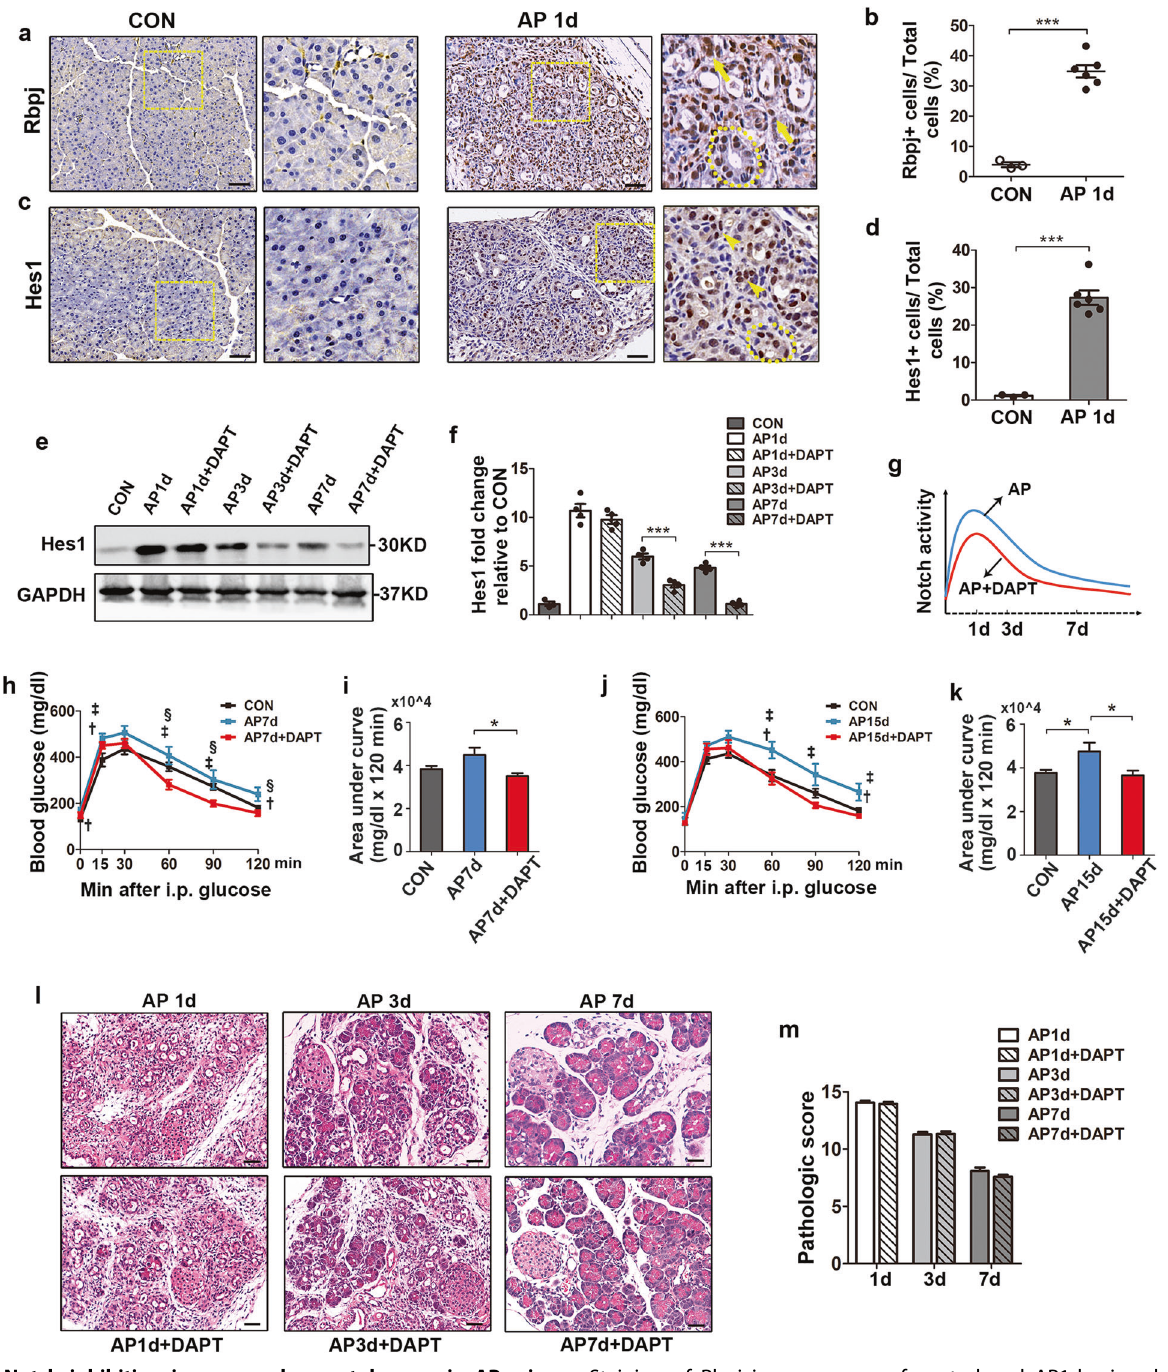
Fig. 5 Notch inhibition improves glucose tolerance in AP mice. a Staining of Rbpj in pancreases of control and AP1d mice showing prominent Rbpj immunoreactivity in pancreases of AP mice. b Quanti fi cation of Rbpj + cells (shown as %) in pancreases from control and AP1d mice. c Immunostaining of Hes1 in pancreases of control and AP1d mice showing prevalent Hes1 staining in pancreases of AP1d mice compared with control pancreases. d Quanti fi cation of Hes1 + cells (shown as %) in pancreases from control and AP1d mice. e Representative western blots of Hes1 in pancreases from control mice, AP mice and AP mice treated with DAPT. f Quanti fi cation of western blots for Hes1 in pancreases from AP mice and AP mice treated with DAPT in relative to control mice. g Schematic representation of Notch activity in pancreases from AP mice and mice treated with DAPT at indicated time points. h , i Blood glucose levels and AUCs during the IPGTT performed in AP7d mice and corresponding DAPT-treated mice, in comparison with control mice ( n = 7, 7 and 10 in CON, AP7d and AP7d + DAPT group, respectively; † p < 0.05, CON vs AP7d; ‡ p < 0.05, CON vs AP7d + DAPT; § p < 0.05, AP7d vs AP7d + DAPT). j , k Blood glucose levels and AUCs during the IPGTT performed in AP15d mice and corresponding DAPT-treated mice compared with that of control mice ( n = 6, 7 and 8 in CON, AP15d and AP15d + DAPT group, respectively; † p < 0.05, CON vs AP15d; ‡ p < 0.05, AP15d vs AP15d + DAPT). l , m Representative H&E staining and pathologic scoring of pancreases from control mice, AP mice and DAPT-treated mice at indicated time points. AP, acute pancreatitis; CON, control; i.p., intraperitoneal; IPGTT, intraperitoneal glucose tolerance test. Data are mean ± SEM, n = 3 – 6. * p < 0.05, *** p < 0.001. Scale bars, 50 μ m.